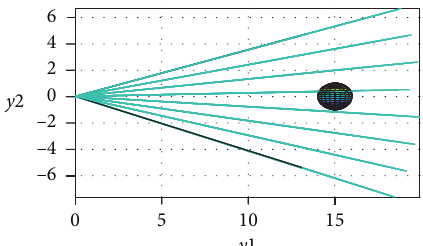
Figure 7: Vertical projection of the 3D lidar’s view for three obstacles in 15 m.